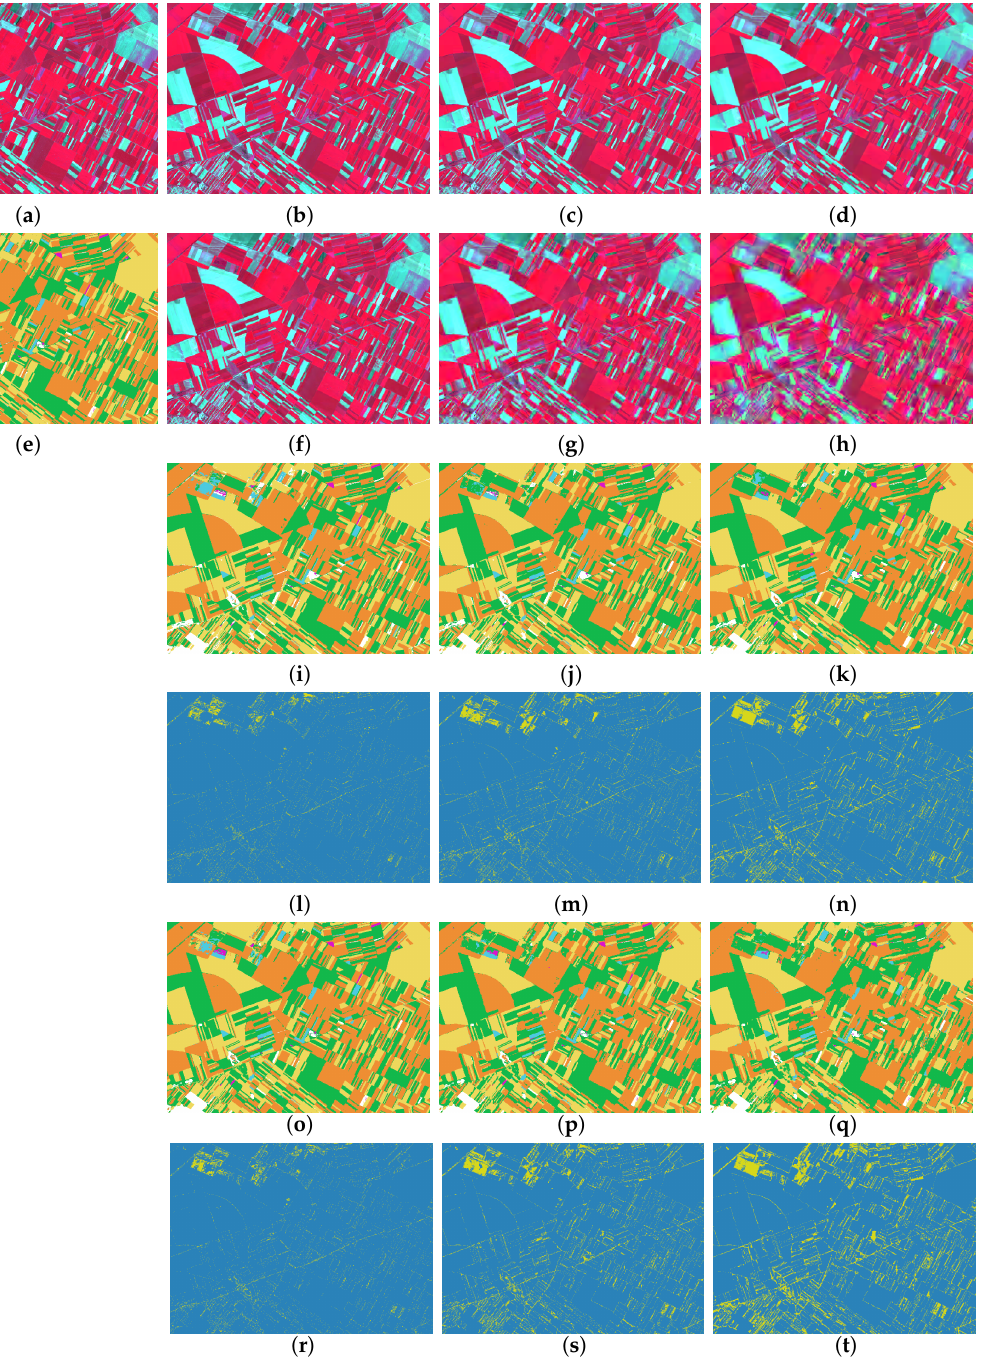
Figure 11. Illustration of the compression effects on the quality of generated crop thematic maps. Each of the columns 2–4 gives visual insights into sensitivity at achieved image compression ratios (CRs) of approximately 25:1 , 75:1 , and 200:1 , respectively. Classification map ( e ) in the first column is based on the the original, uncompressed image time series, shown in ( a ). Images ( b – d ) and ( f – h ) are the NIR-red-green false color composites of the same scene detail produced by the HEVC and the JPEG 2000 for the considered CRs, respectively. Similarly, group of images ( i – k ) are the crop thematic maps made by classifier instances tbased on the proposed HEVC solution, while the maps ( o – q ) are the results of applying JPEG 2000. Differences between HEVC based classification maps ( i – k ), as well as JPEG 2000 based maps ( o – q ), in comparison to the original map (e) are illustrated by the yellow pixels in ( l – n ) for the HEVC, and ( r – t ) for the JPEG